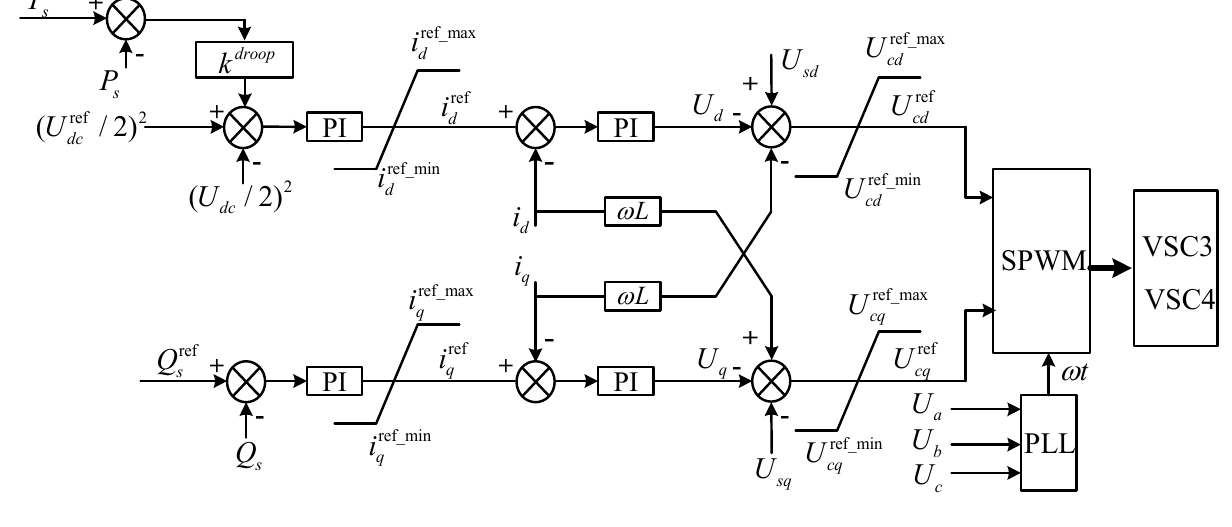
Figure 6. Control block diagram of onshore